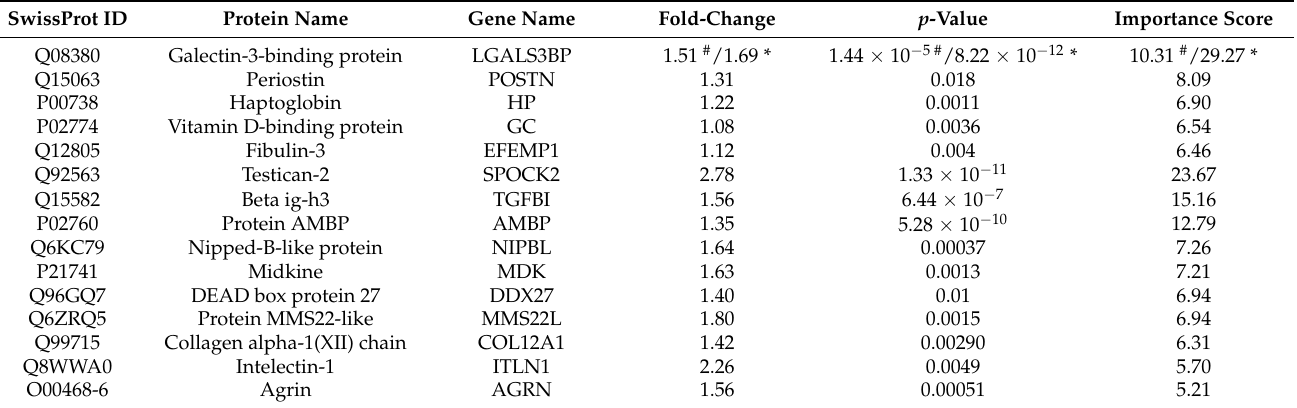
Table 2. Proteins with the capability to discriminate MPM pleural effusions from controls identified by the Boruta feature selection algorithm as described in Section 2.5. Galactin-3-binding protein was identified in both datasets whereas periostin, haptoglobin, vitamin D-binding protein, and fibulin-3, were identified in the dataset comprising of high-abundant proteins. The remaining proteins were only identified in the dataset with the low-abundant proteins.